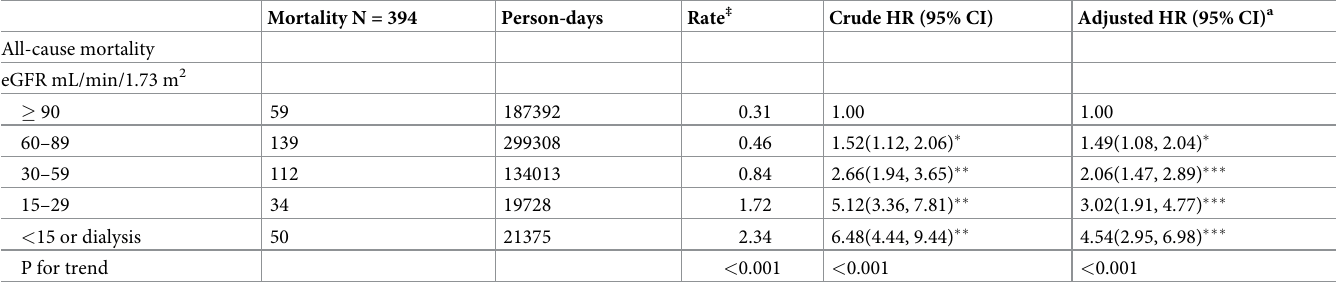
Table 3. Incidence and hazard ratios of mortality at 1 year after intracerebral hemorrhage by eGFR levels on admission.